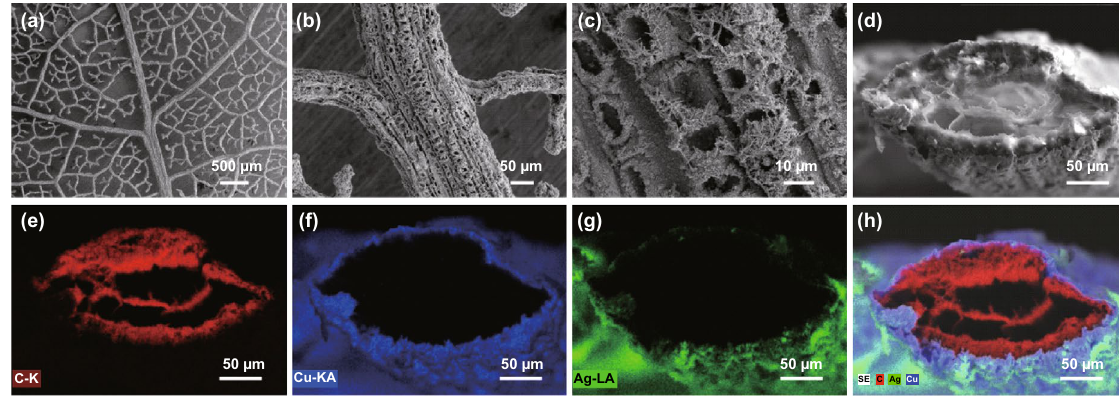
Fig. 3 Encapsulation by electroplating of Ag on Cu‑plated veins. a SEM images of electroplated Ag on a Cu‑plated Populus × canescens leaf vein network. b Details on the midrib. c Ag dendrites grown on the midrib. d Secondary electron (SE) image at the cross section of the midrib. e EDX mapping of the carbon Kα‑line at the cross section of the midrib. f EDX mapping of the Cu Kα line. g EDX mapping of the Ag Lα line. h Mixed colour EDX mapping of the three elements and the SE image